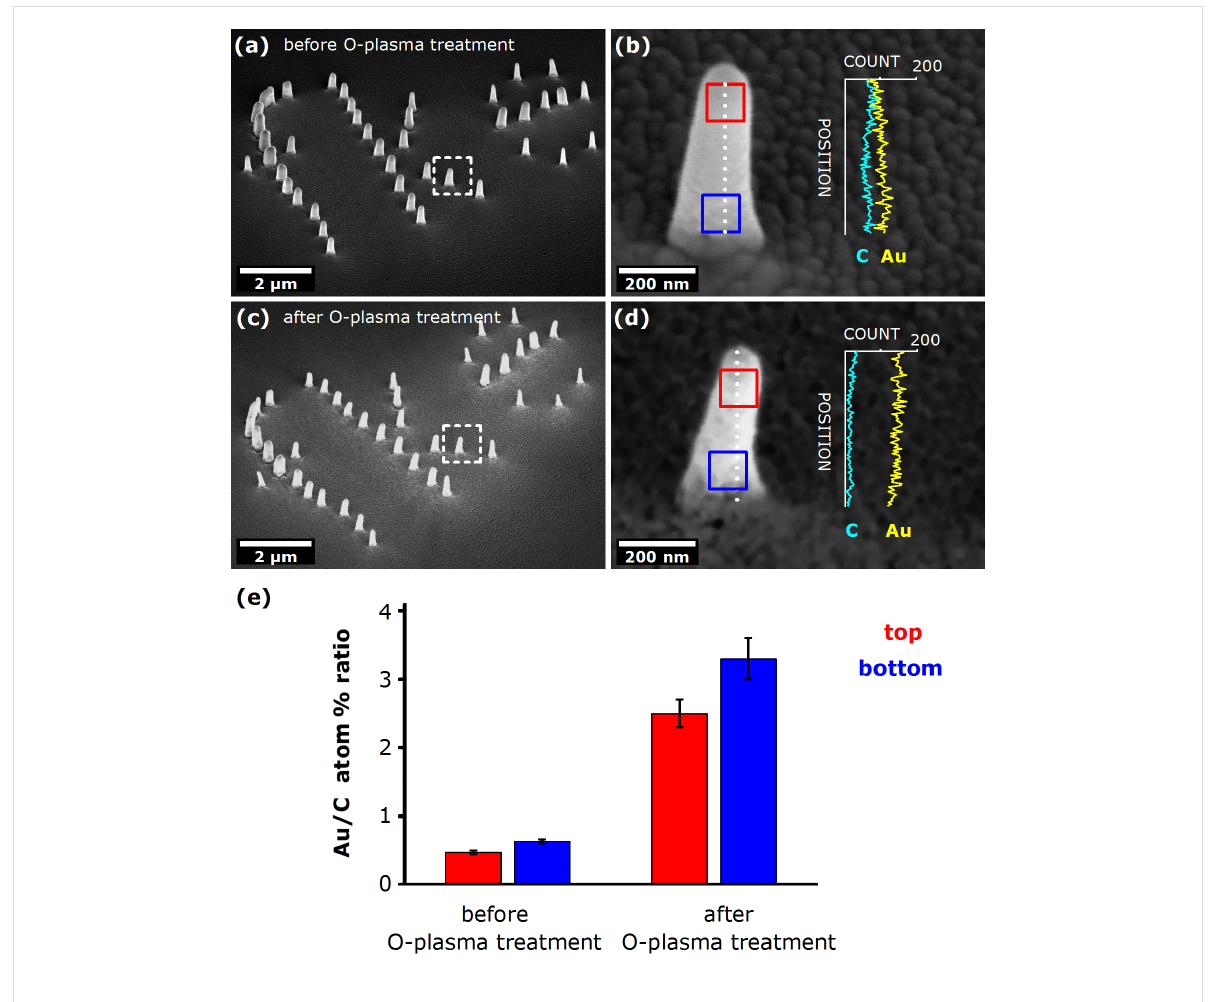
Figure 4: (a) SEM image (tilted view) of the test configuration of patterned pristine Au nanopillars (NPs). Note the variation in the number of neigh- bouring NPs, i.e., adjacent NPs within 1 μ m distance; (b) Close-up view on a single pristine NP from the pattern having 2 neighbouring NPs, with the EDX line profile given in the inset; (c) SEM image (tilted view) of the same configuration after the O-plasma treatment; (d) Close-up view on the same NP as in (b), with the EDX line profile given in the inset. (e) Elemental composition of the top and bottom parts of Au NPs presented in (b,d) acquired before and after O-plasma treatment, expressed as Au/C atom % ratio. The EDX measurements were performed on 100 × 100 nm 2 areas marked with the red and blue squares in b,d, for a period of 60 s. For detailed EDX data see Table S3 in Supporting Information File